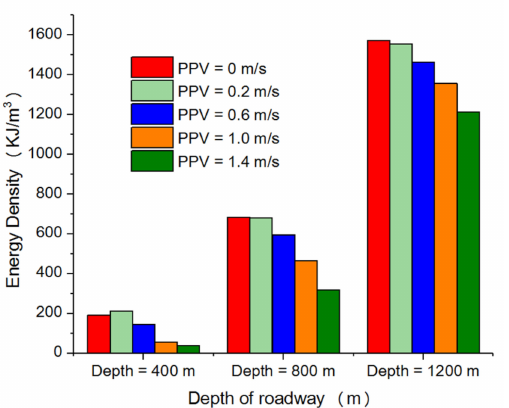
Figure 11. Variations in the elastic energy density in the area of the peak abutment stress under di ff erent dynamic and static loading conditions.